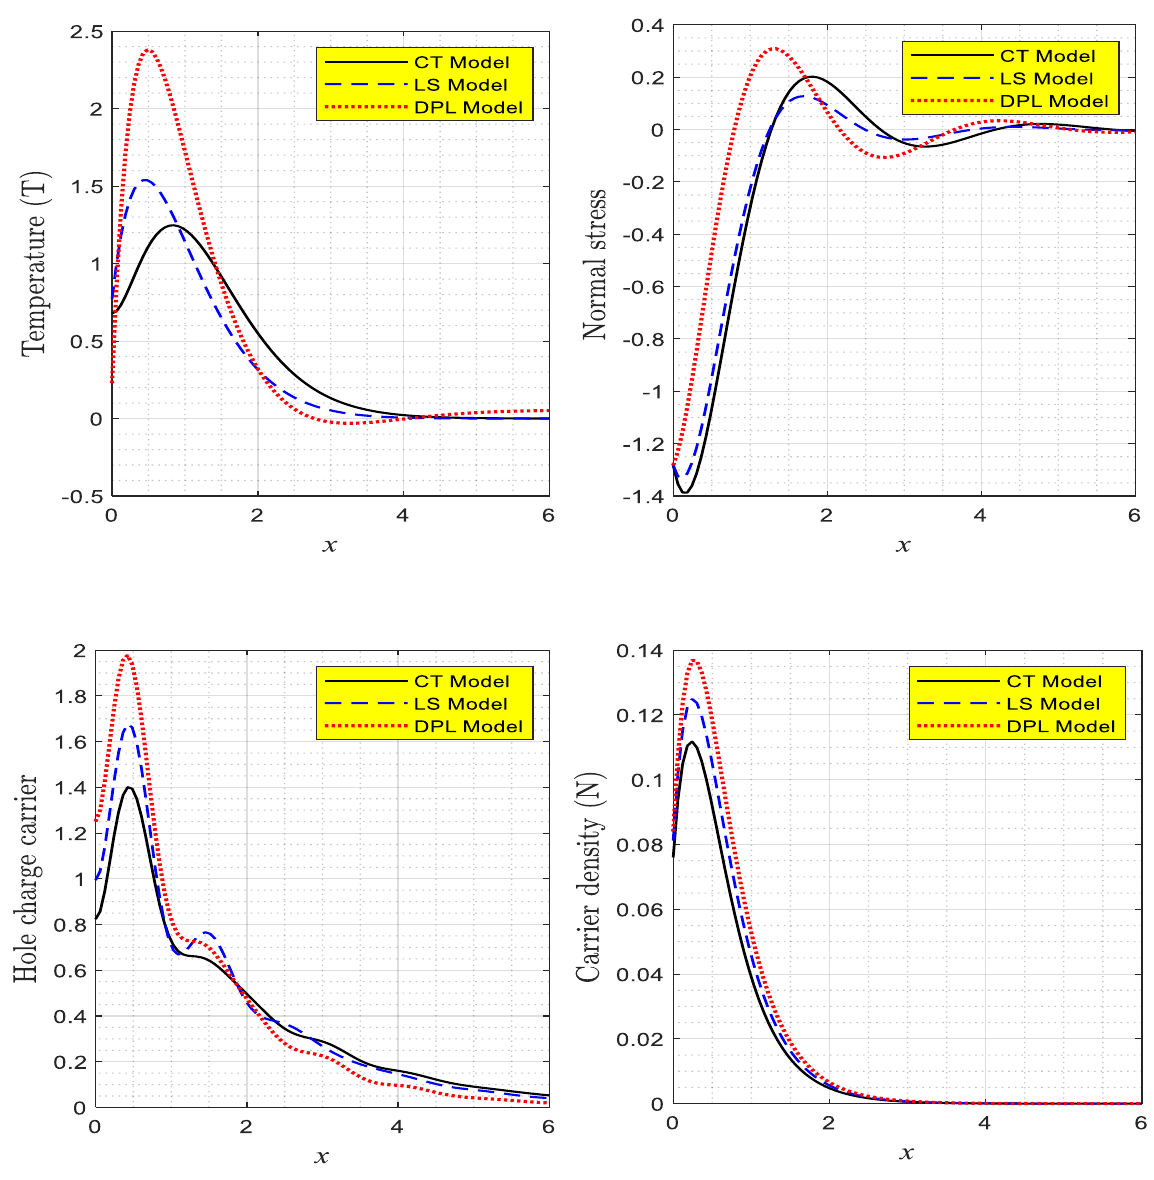
Figure 2. According to photo-thermoelasticity models with varying thermal conductivity under the influence of Hall current, the principal non-local physical distributions change with